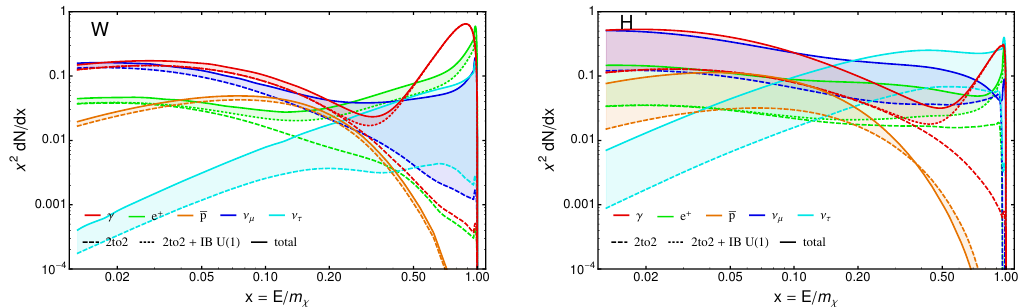
Figure 14 . Same as (cid:12)gure 11, but for a Bino-like neutralino with almost degenerate Wino (W, left) and a model with large Hf (cid:22) f contribution (H, right). The features in the shape of the lepton and gamma ray spectra are due to an interplay of various e(cid:11)ects as discussed in detail in the text. Left panel : bino-like neutralino with almost degenerate Wino (benchmark model W). Final state channels: photons (red), antiprotons (orange), positrons (green), (cid:23) (cid:22) (blue), and (cid:23) (cid:28) (cyan). Solid lines indicate the total (two-body and three-body) contribution, the dashed lines the two-body process. Right panel : large Hf (cid:22) f contribution (benchmark model